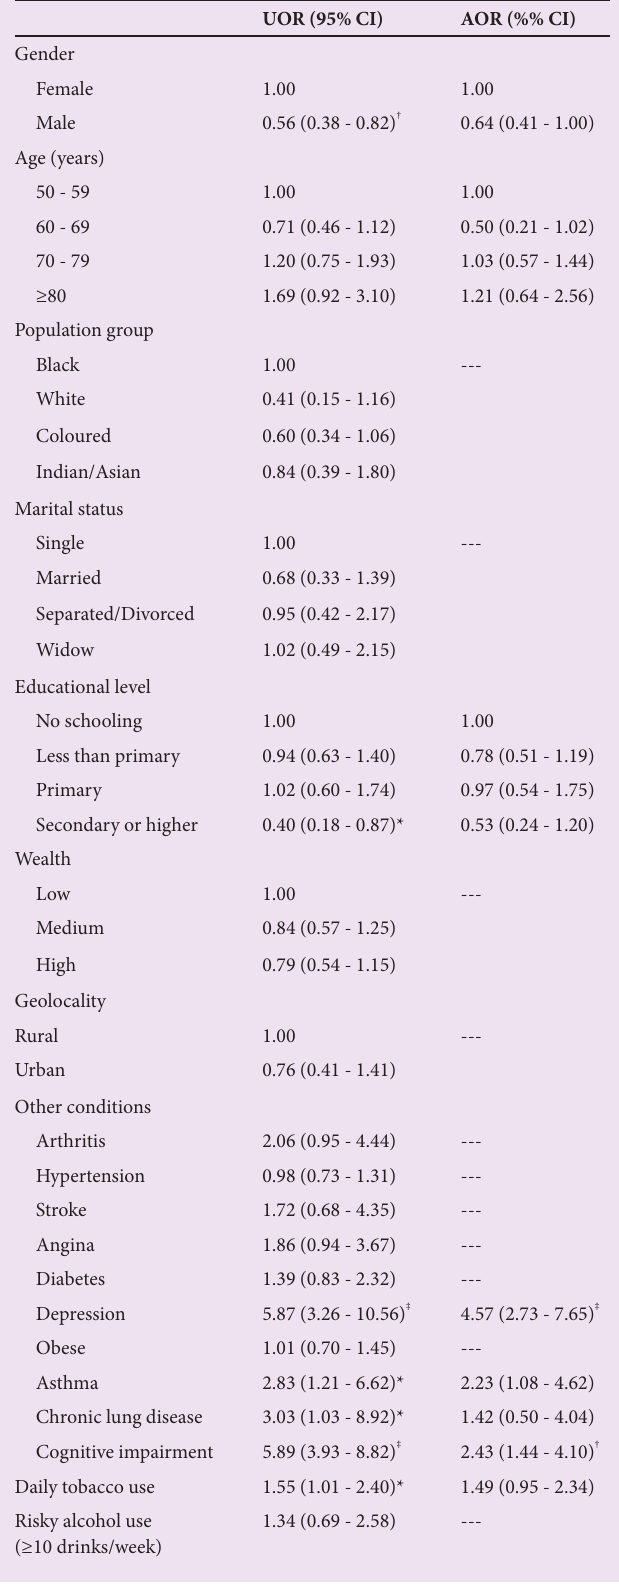
Table 2. Multivariable logistic regression with sleeping problem in older South